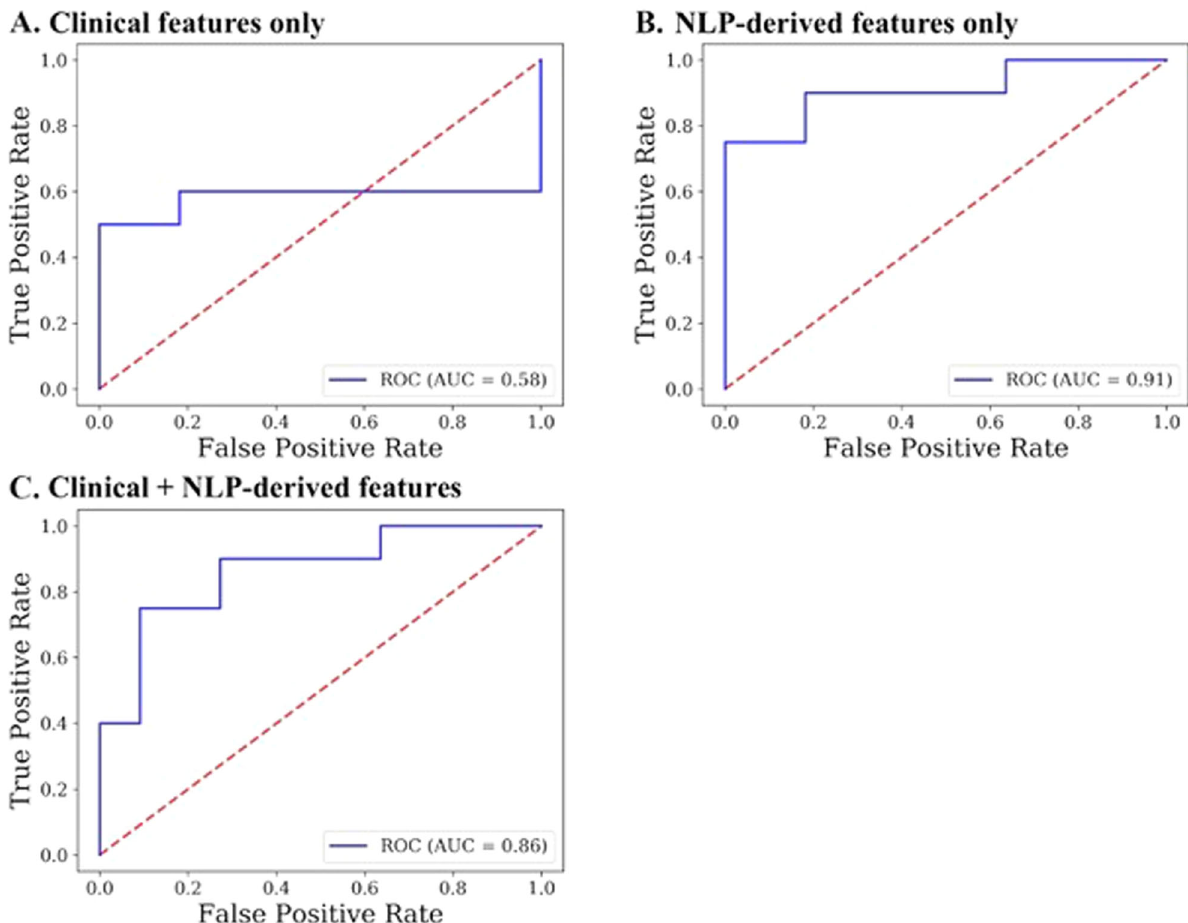
Fig. 3 Discrimination between SSD and HC group status. Naive Bayes models with leave-one-out cross-validation were constructed for ( A ) Clinical features alone, from the Scale for the Assessment of Thought Language and Communication (TLC), ( B ) Natural language processing-derived linguistic features alone, and ( C ) A combination of TLC and NLP-derived features. The NLP-only model performed better than the clinical-only model (accuracy 87% compared to 68%) and was similar to the model incorporating both NLP and clinical linguistic features (accuracy